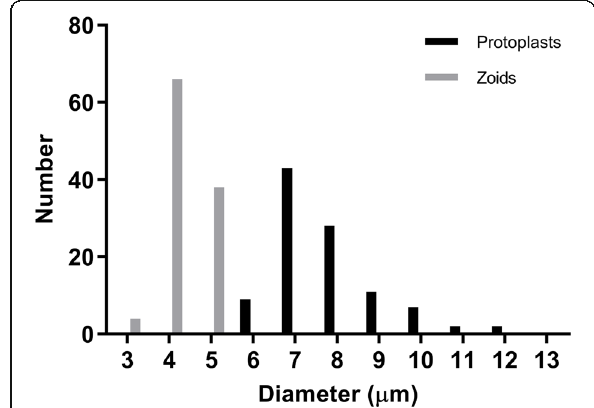
Fig. 3 Distribution of the size of somatic cell protoplasts and zooids from Scytosiphon